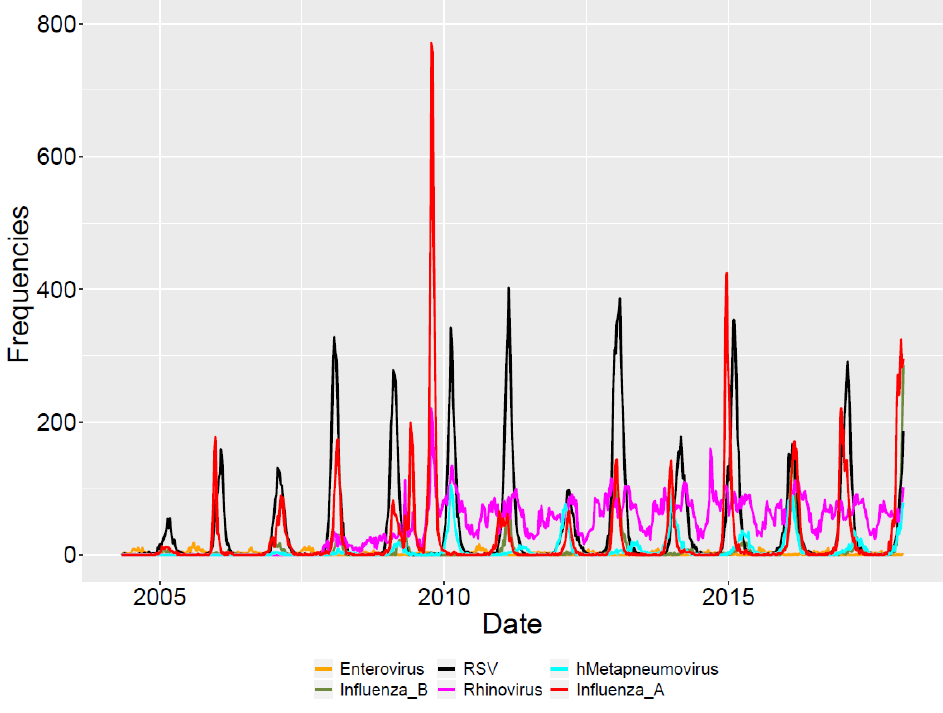
Figure 2. Raw frequency plot.